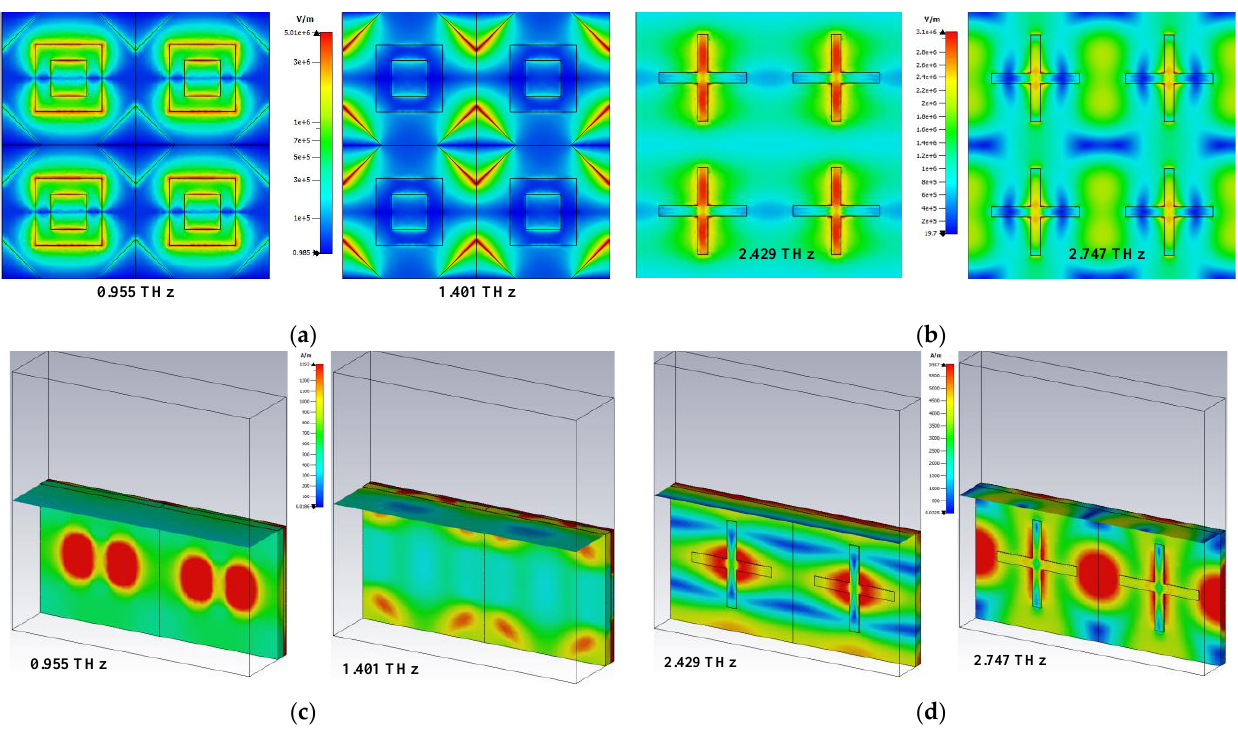
Figure 15. Distribution of electric field for ( a ) SquarePMA, ( b ) CrossPMA and magnetic field for ( c ) SquarePMA, ( d ) CrossPMA for sensors loaded with 10 µm thick H9N2 sample at the resonant frequencies.